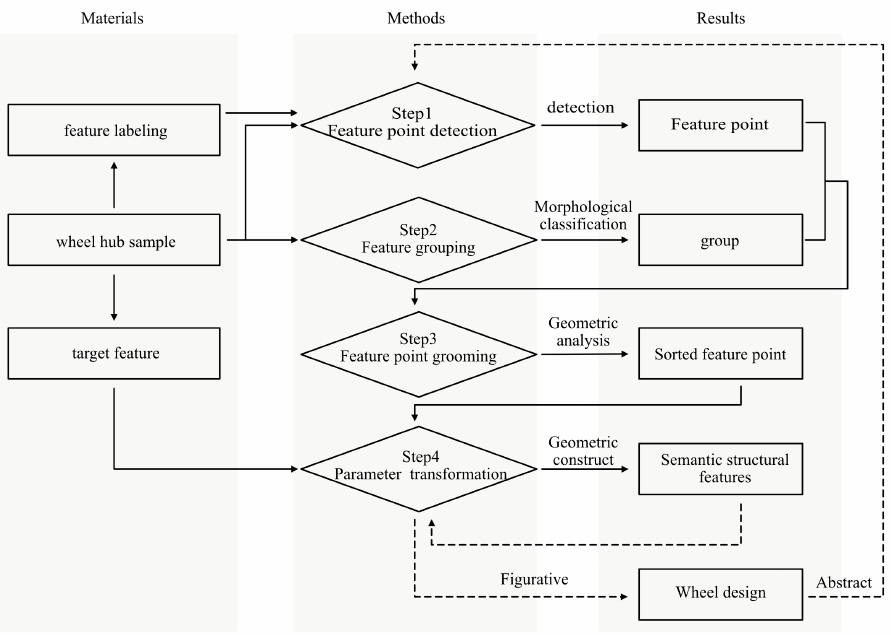
Figure 1. Research process. Step 1 and step 2 decompose the wheel hub sample into feature points and feature groups, while step 3 and step 4 convert the feature points into semantic structural features. Step 4 can also be used to convert features into point coordinates for shape generation.